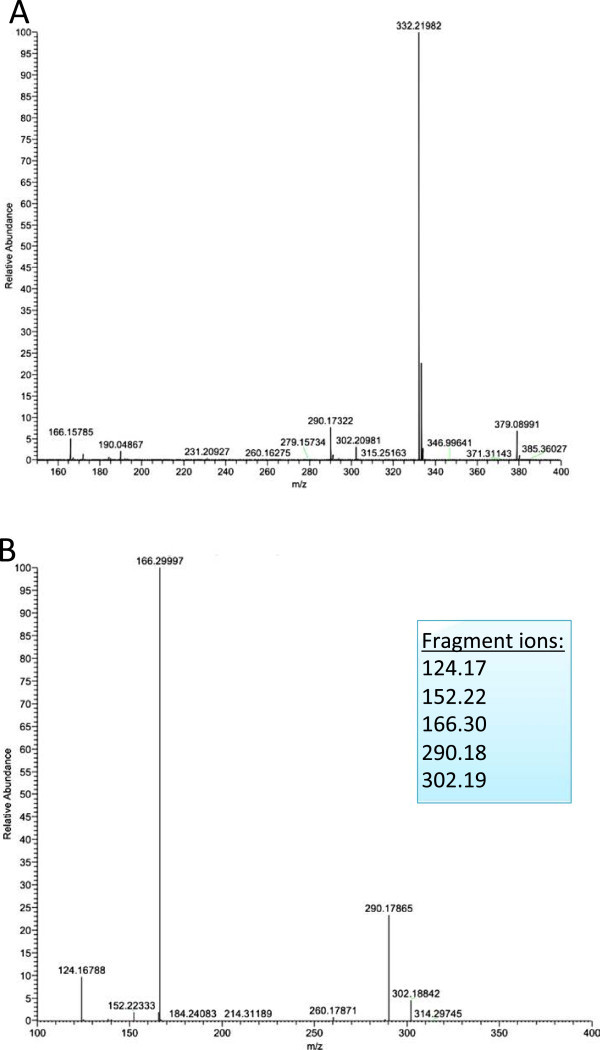
Ipratropium identification within the pulmonary compartment with smooth muscle cells: (A) parent ion (m/z332.332) and (B) fragmentation pattern (m/z124, 17, 152, 22 166.2 and 290.2).